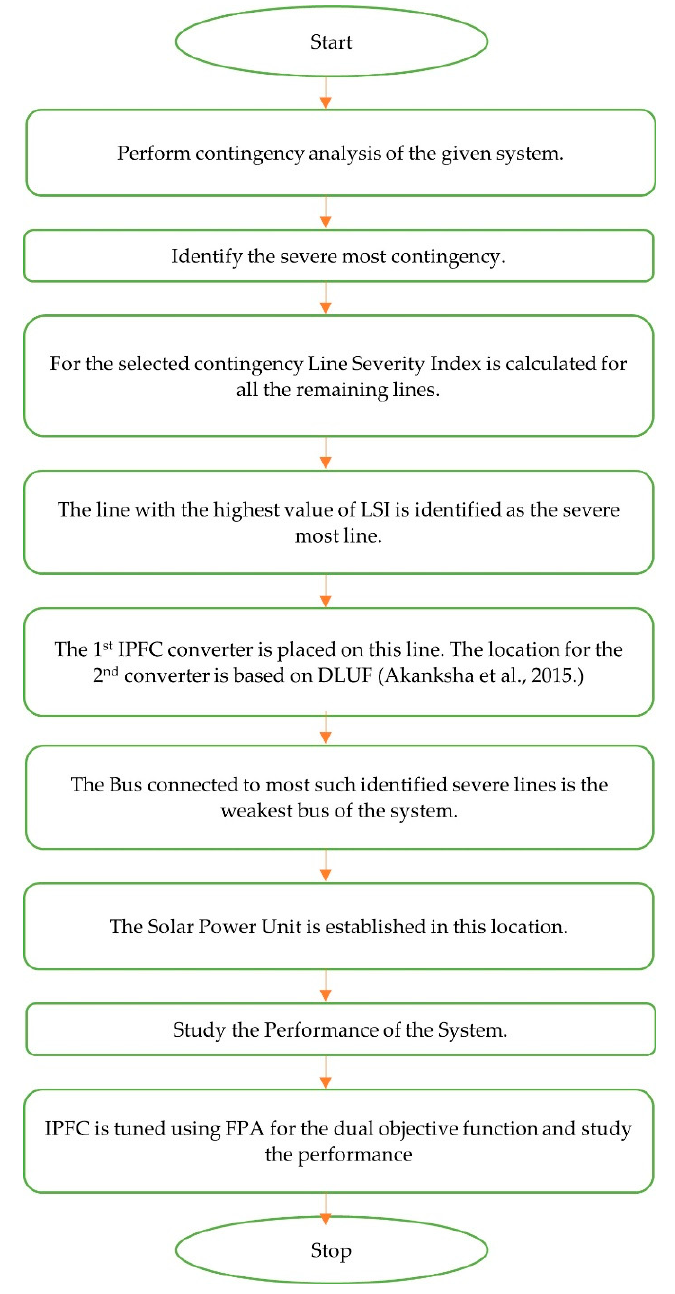
Figure 2. Methodology followed for Solar Power and IPFC placement and tuning [14].